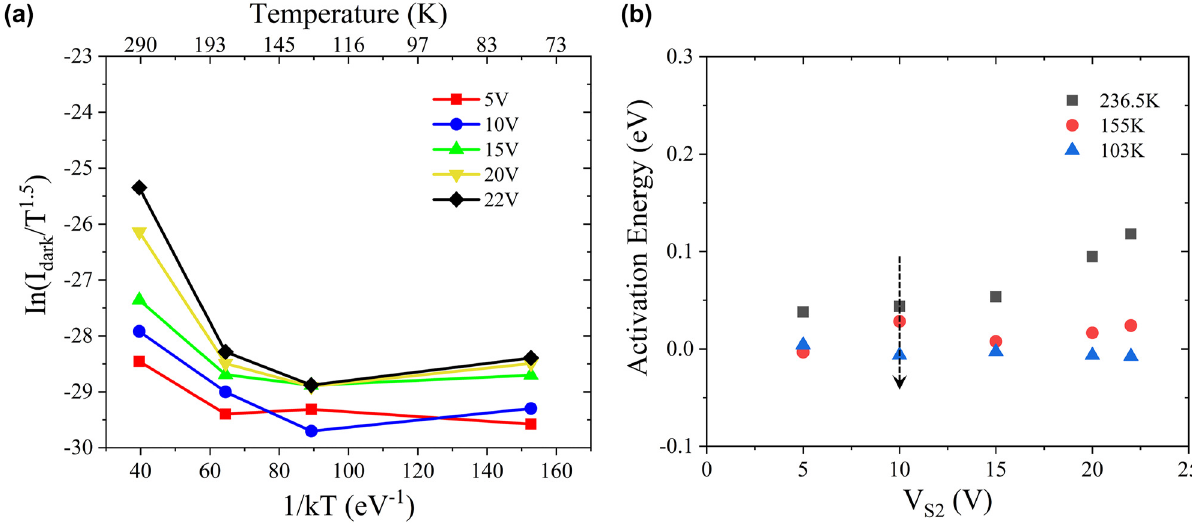
Figure 5: Dark current and activation energy calculation. (a) The Arrhenius plot of the I temperature 293 K, 180 K, 130 K, and 78 K. (b) The evolution of E